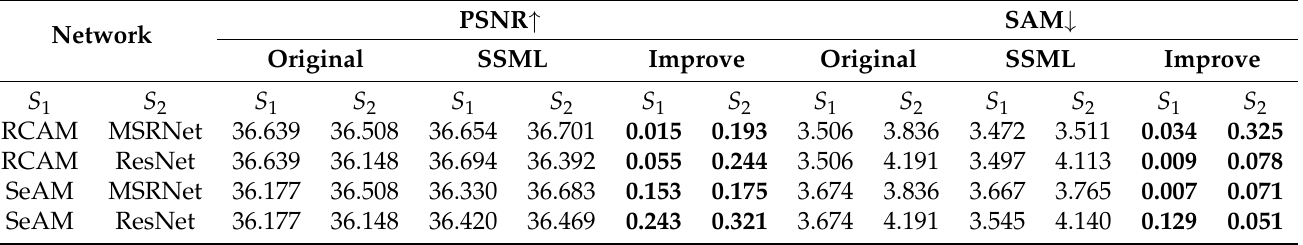
Table 3. Comparison results of the SSML for different deep networks on the CAVE dataset.